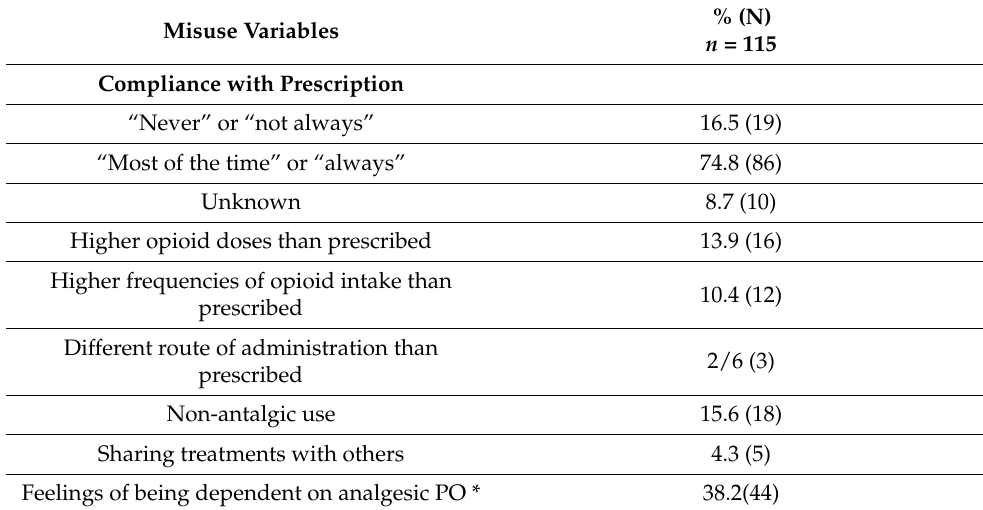
Table 2. Characteristics of opioid